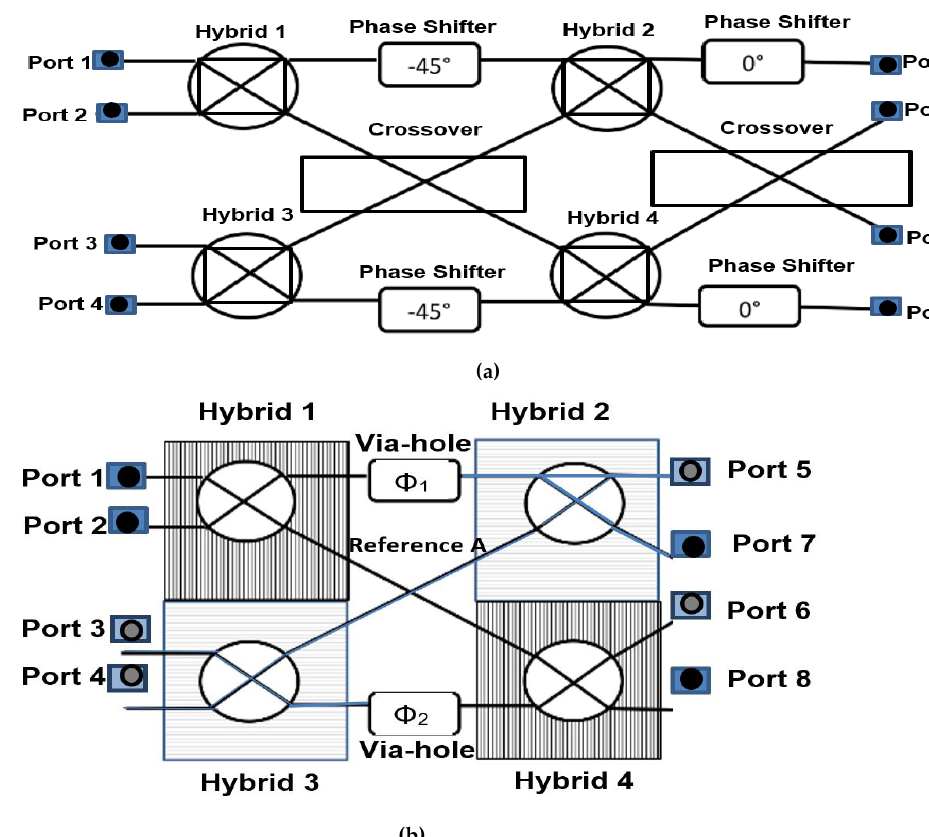
Figure 9. Butler matrix structure: ( a ) conventional and ( b ) using a via-hole. Due to its high complexity, this project proposed a new method by circumventing the crossover structure. Implementing the dual-layer structure with a via-hole to connect between these two layers avoids crossover connections, which reduces the size of the BM and reduces losses. The circular slot is designed at the common ground at the centre be- tween these two layers to improve the performance of the insertion loss and the phase transition. The structure is compact, where the two sides of the hybrid are stacked side by side (Hybrid 1 and Hybrid 2) with Hybrid 1 at the upper layer and Hybrid 2 at the lower layer. This is applicable to Hybrid 3 and Hybrid 4, as shown in Figure 9b. The new con- figuration is simplified, where the crossover and the phase shifter are circumvented in the BM design.